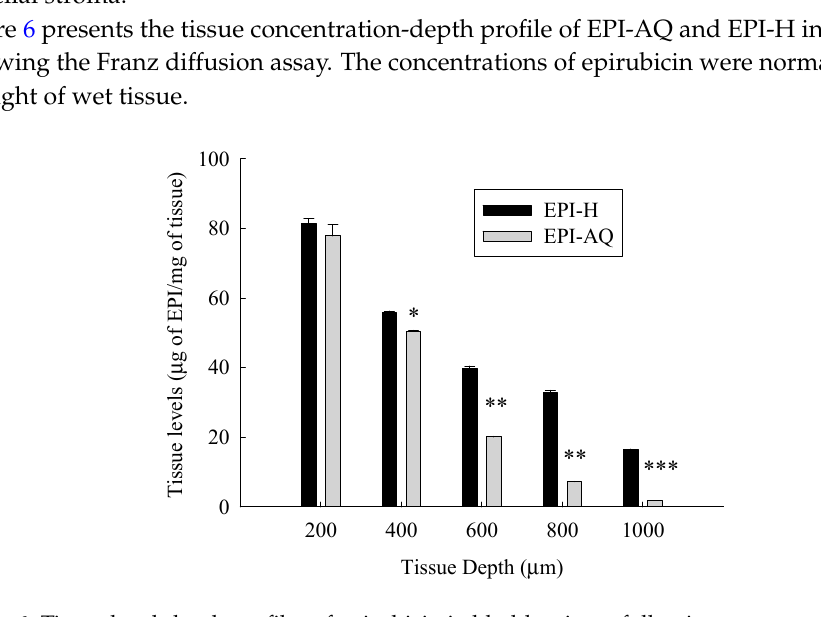
Figure 6. Tissue level-depth profiles of epirubicin in bladder tissue following exposure to 2 mg/mL EPI-AQ or EPI-H formulations. Tissues were incubated for 2 h and sectioned by cryotome. Values are means ± SEM ( n = 3). * p < 0.05, ** p < 0.01 and *** p < 0.001 in cases of EPI-AQ vs. EPI-H.